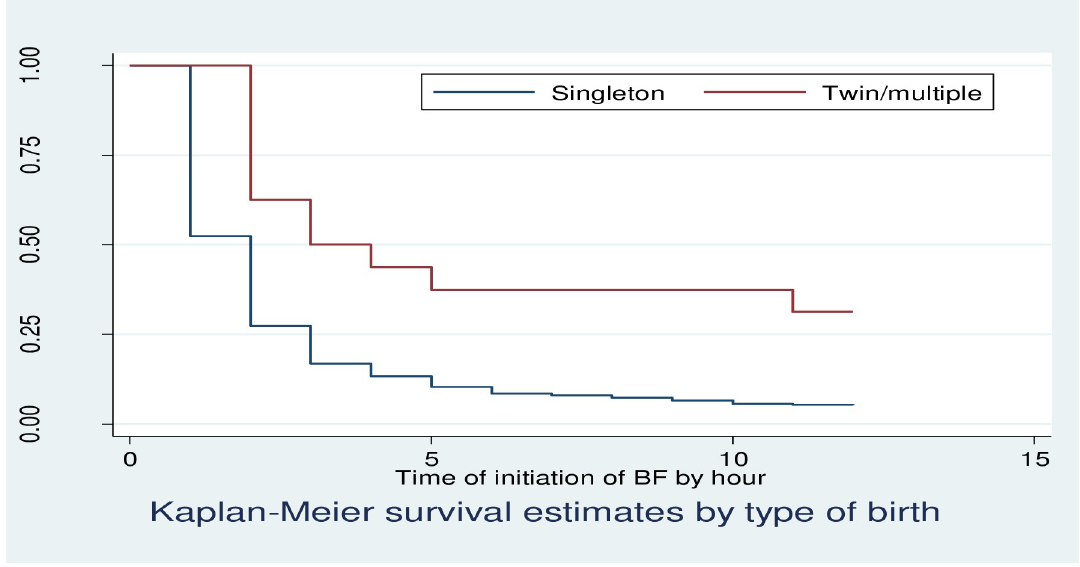
Fig 2. KM survival estimates by birth type among postnatal mothers within 12 hours of giving birth in Debre Markos Comprehensive Specialized Hospital, North West, Ethiopia, 2020.